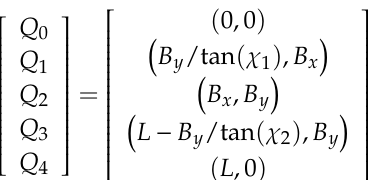
Figure 3. Camber curve parameterization.